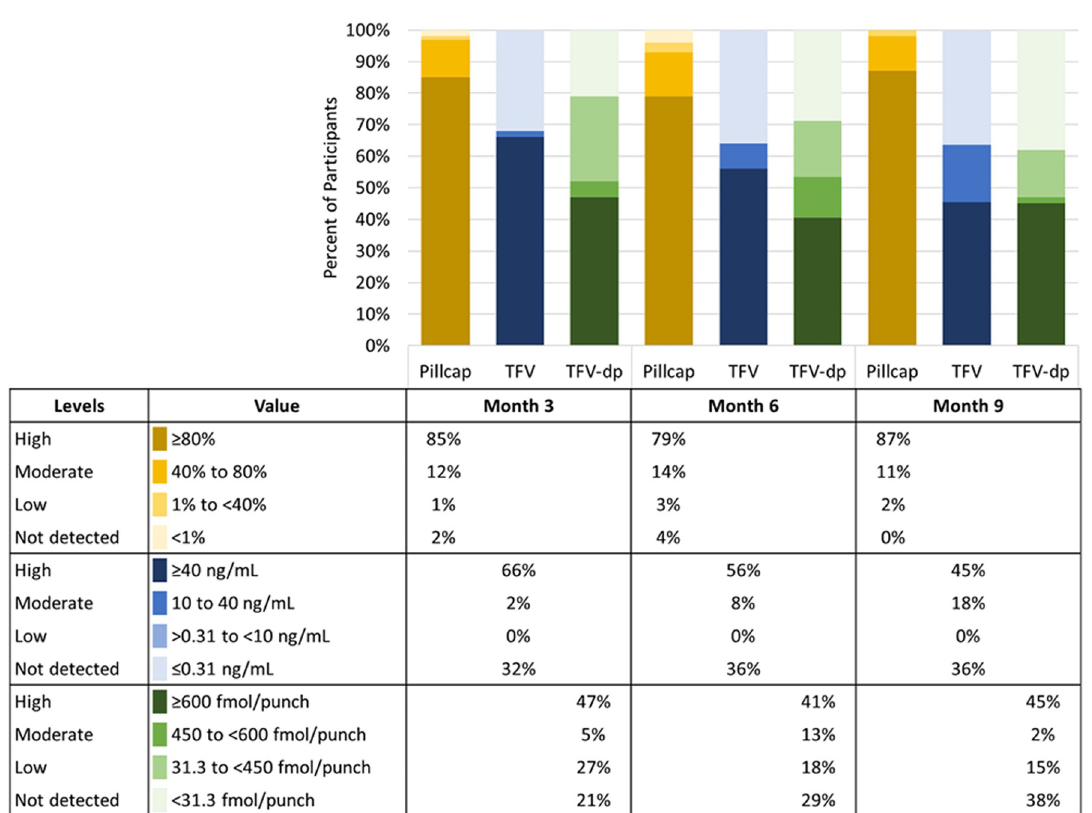
Fig 4. Periconception adherence at 3, 6, and 9 months using 3 assessment